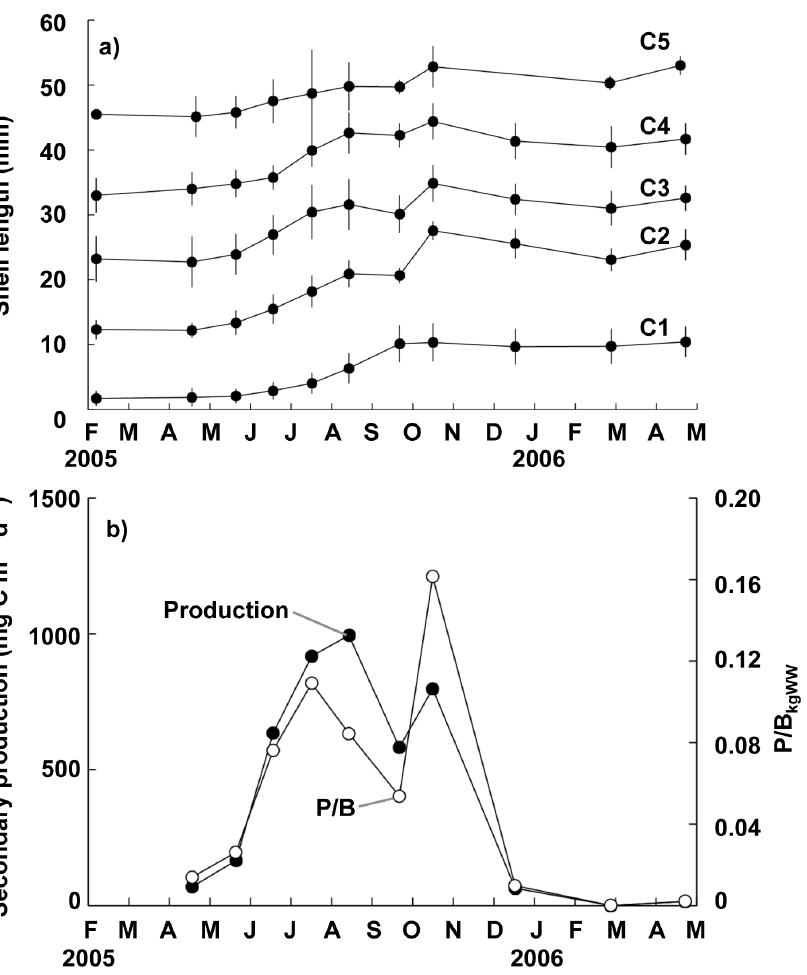
Figure 4. Seasonal variation of growth of the clam ( Ruditapesphilippinarum ) at station B. Changes in (a) mean shell length of each cohort of the clam Ruditapes philippinarum and (b) daily secondary productivity and P/B kgWW at station B.